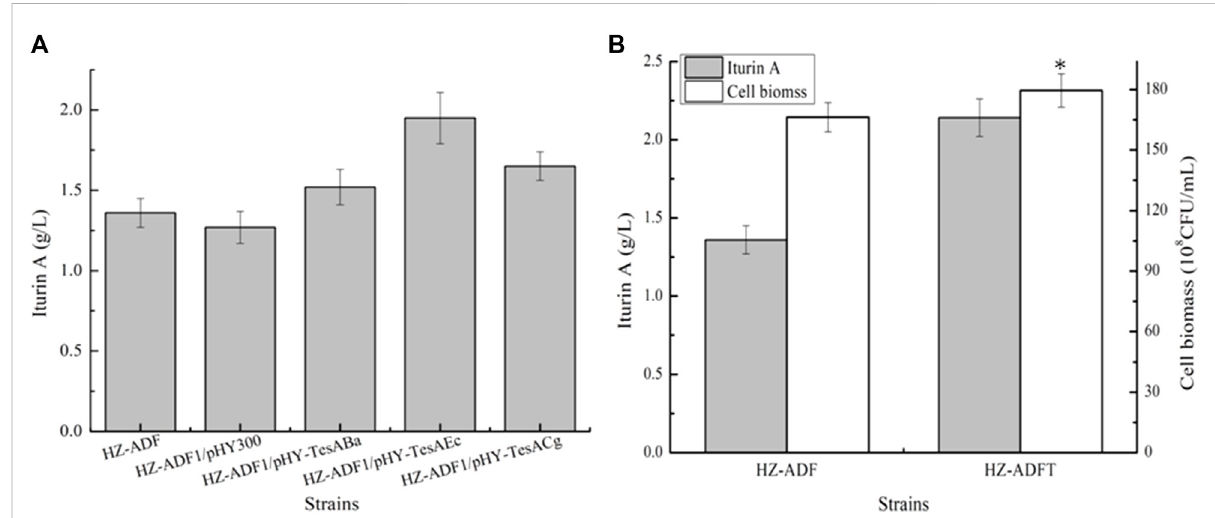
FIGURE 4 Strengthening soluble acyl-ACP thioesterase expression for iturin A production. (A) Effects of overexpression of acyl-ACP thioesterase from different species on iturin A production. (B) Introducing acyl-ACP thioesterase from E. coli for iturin A